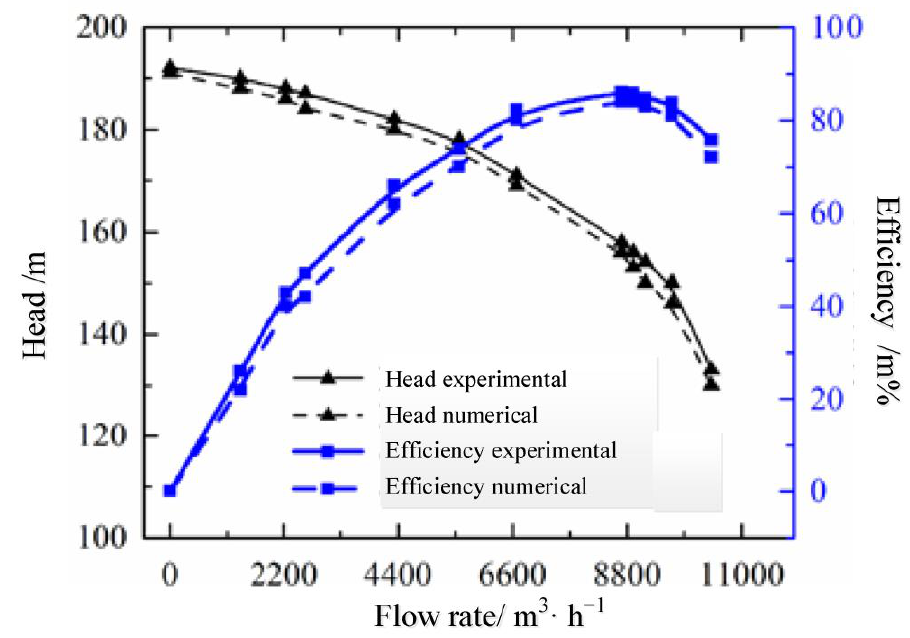
Figure 7. Performance prediction and experiment